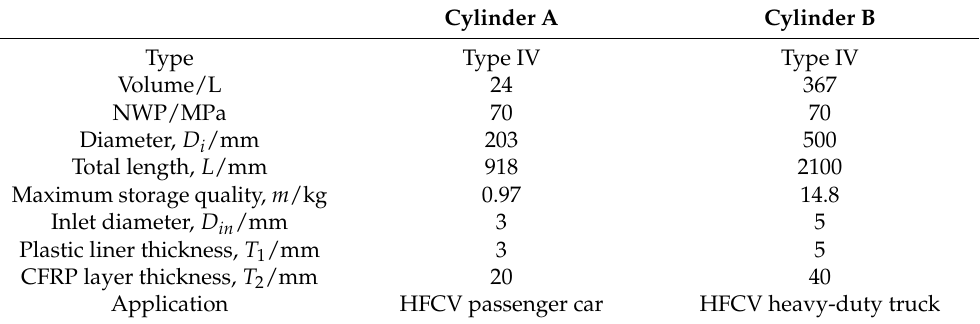
Table 1. Structural parameters of the considered